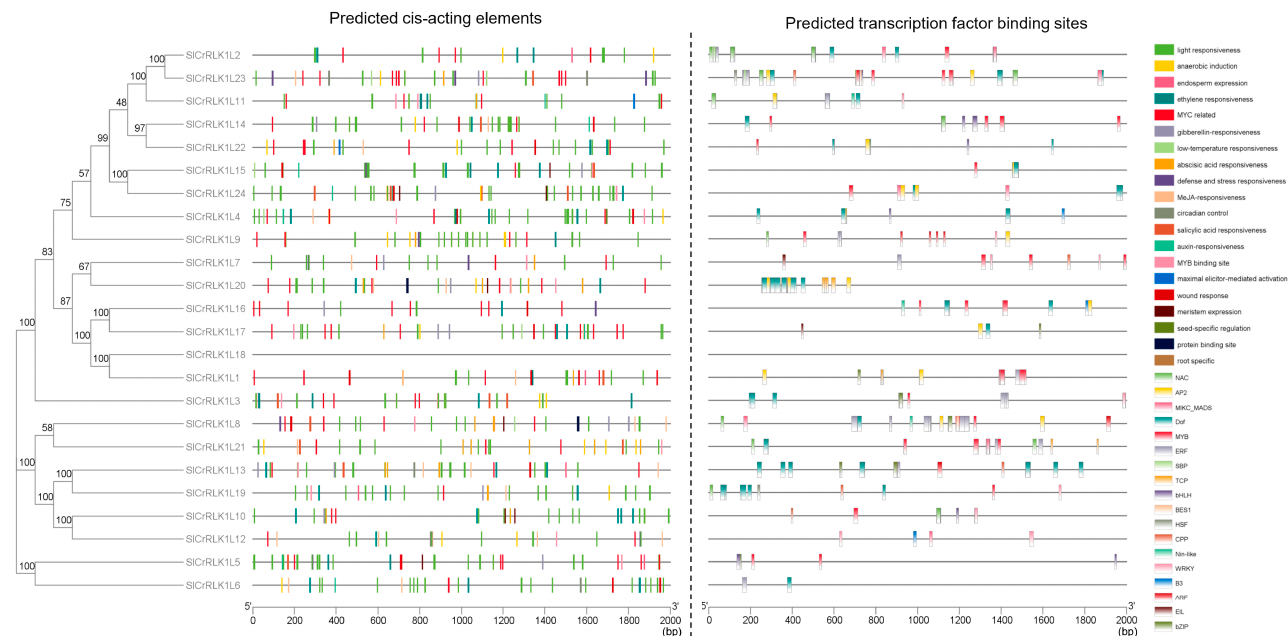
Figure 6. Predicted cis-acting elements and transcription factor binding sites of SlCrRLK1L promotors. The regions are represented by colored rectangles.